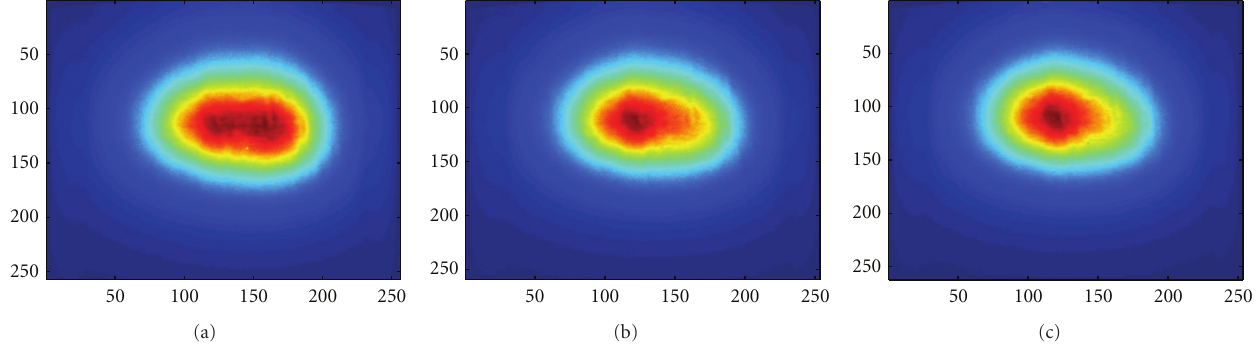
Figure 8: (a)–(c) Front views of measurements by CCD for the case of intensity ratios 1: 1, 2:1, and 4 :1.